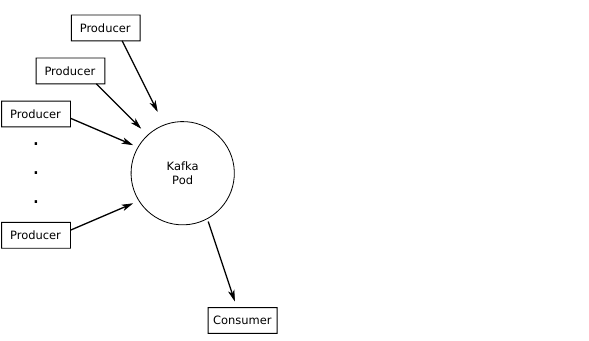
Figure 4. Scheme of the prototype: multiple producers write in the Kafka instance running on a Ku- bernetes’ pod, a single consumer reads from